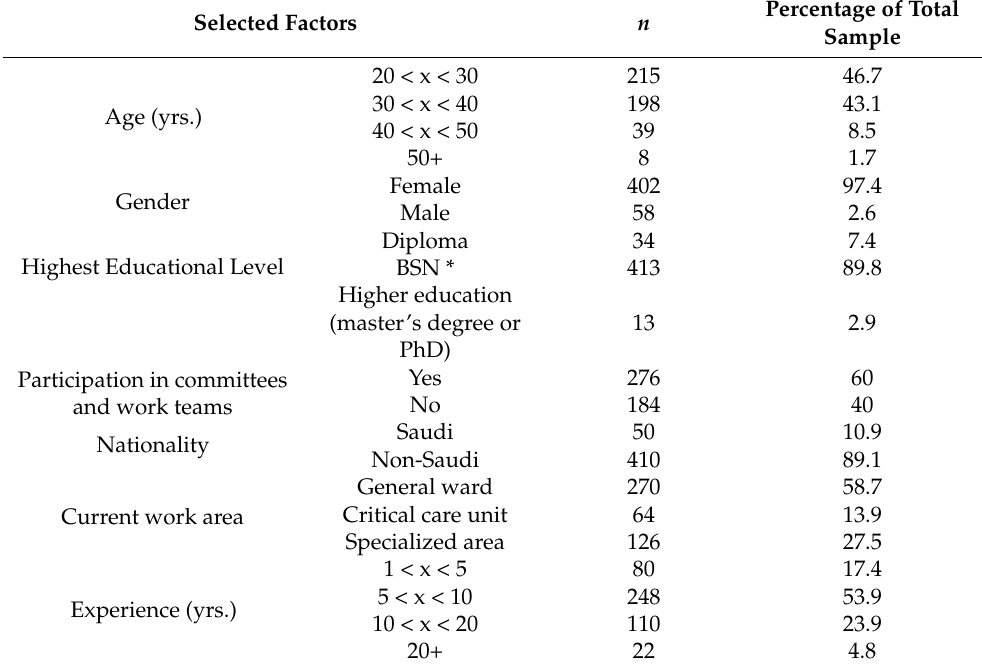
Table 1. Participants’ Characteristics ( n =